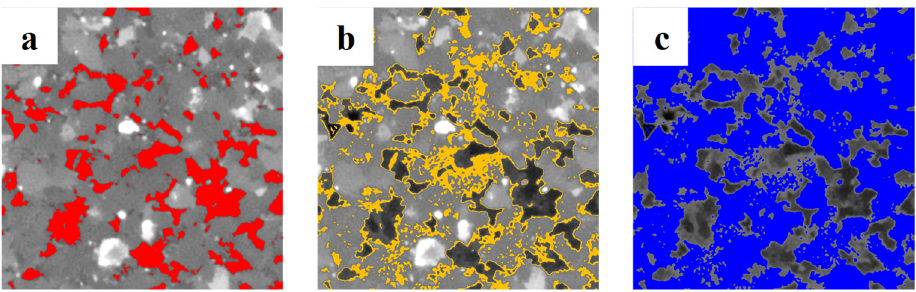
Figure 4. Segmentation classification shown as two-dimensional cross-sections of the three-dimensional images of the same slice. ( a ) Macro-pore, ( b ) Micro-pore, ( c ) Solid grain.